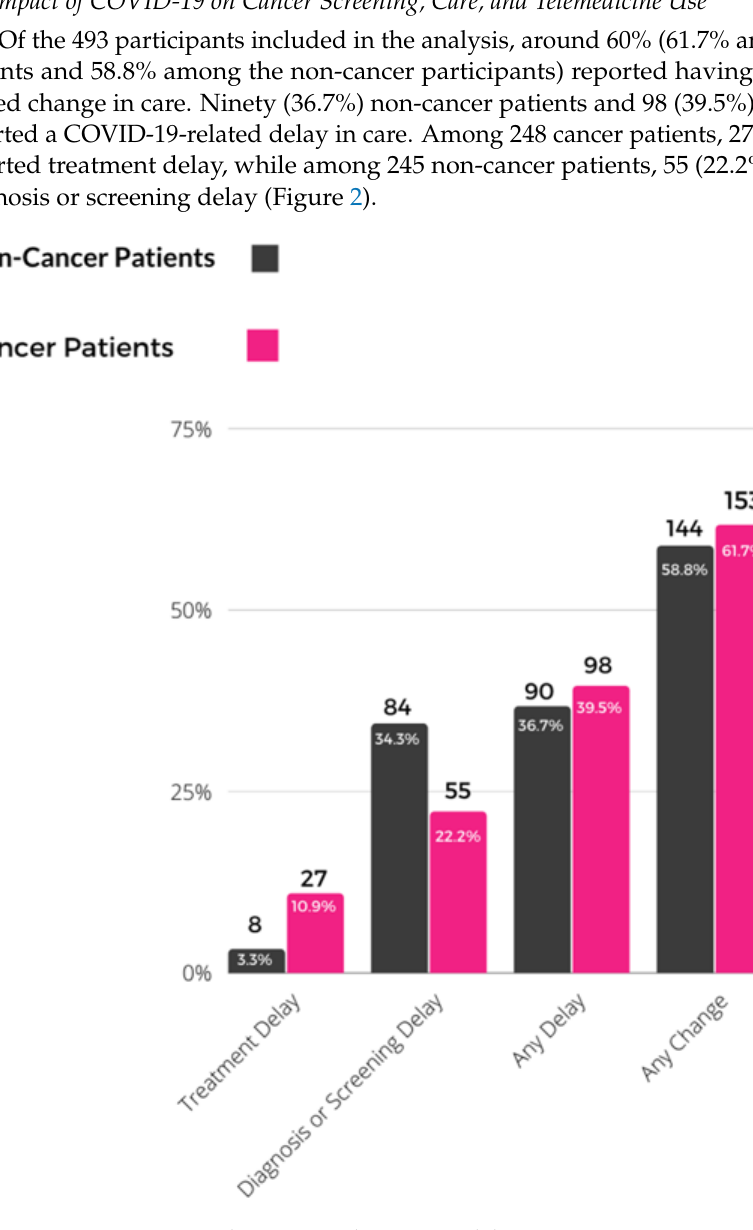
Figure 2. Cancer screening, diagnosis and treatment delay among survey